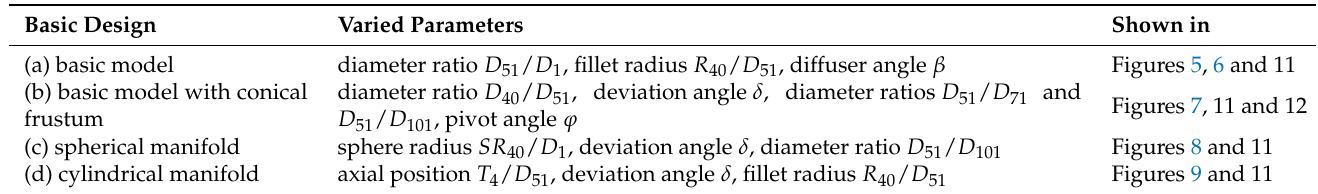
Table 1. Overview of cases and varied parameters.